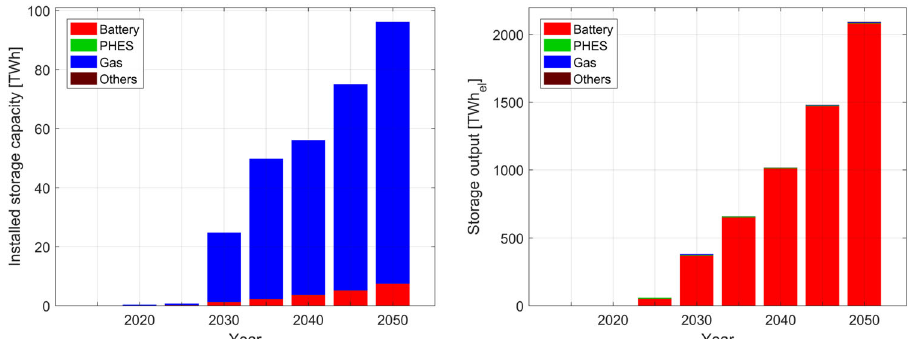
Fig. 4 | Aggerated storage capacity (a) and storage output (b) during the transition from 2015 to 2050 across India. The installed storage capacities